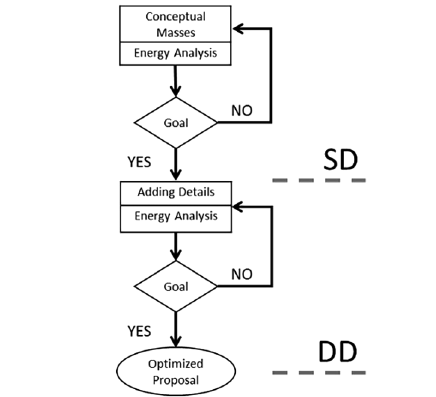
Figure 8. The performance analysis and optimized design decision-making cycle (SD-DD)